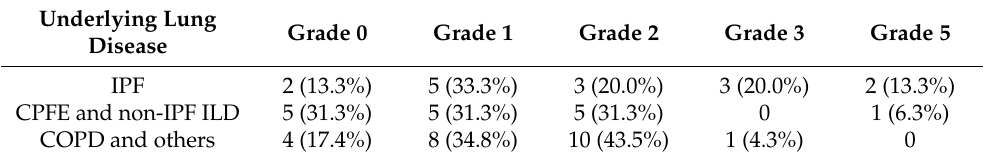
Table 3. Pulmonary toxicity according to underlying lung disease.